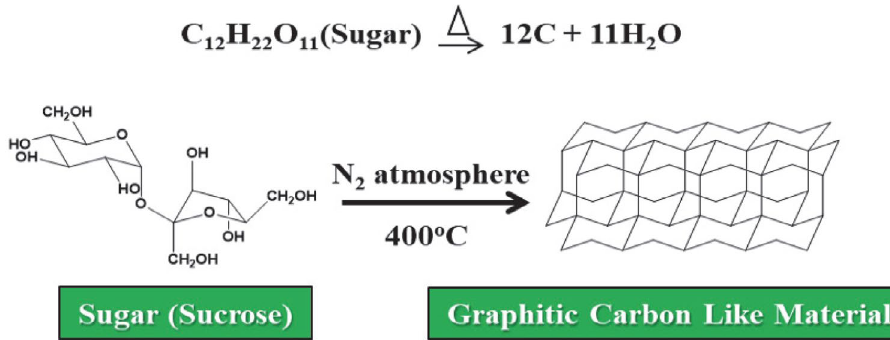
Scheme 1. The schematic representation of the green synthesis of graphitic carbon material (GCM) from edible